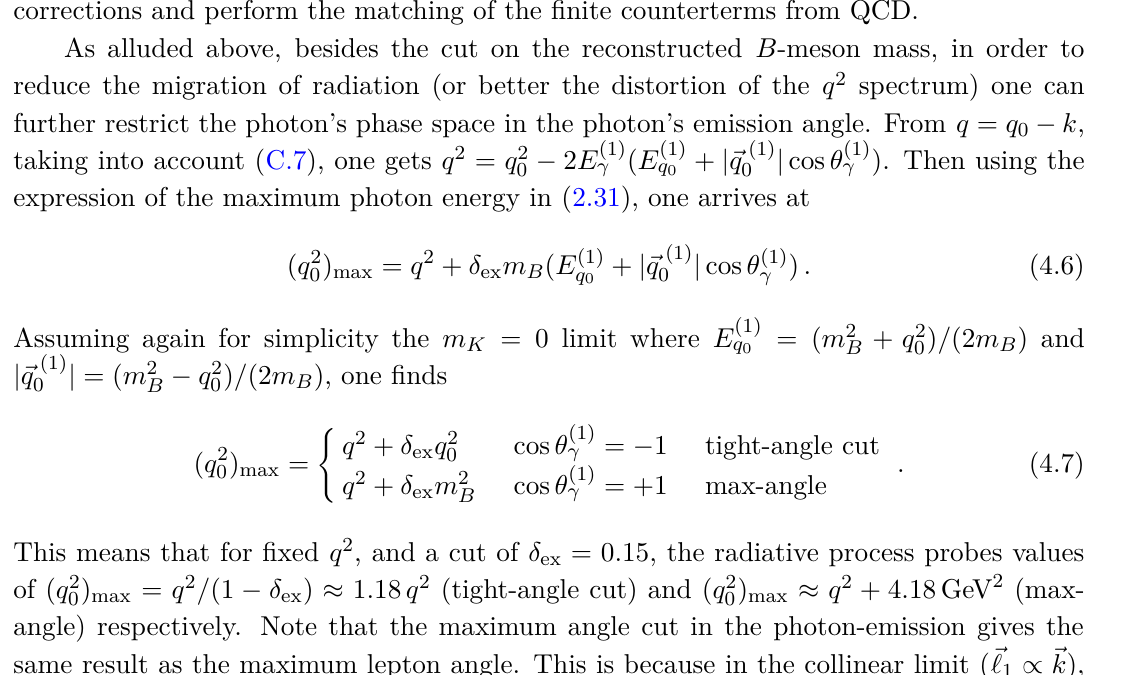
-variables to differ. In the neutral 0